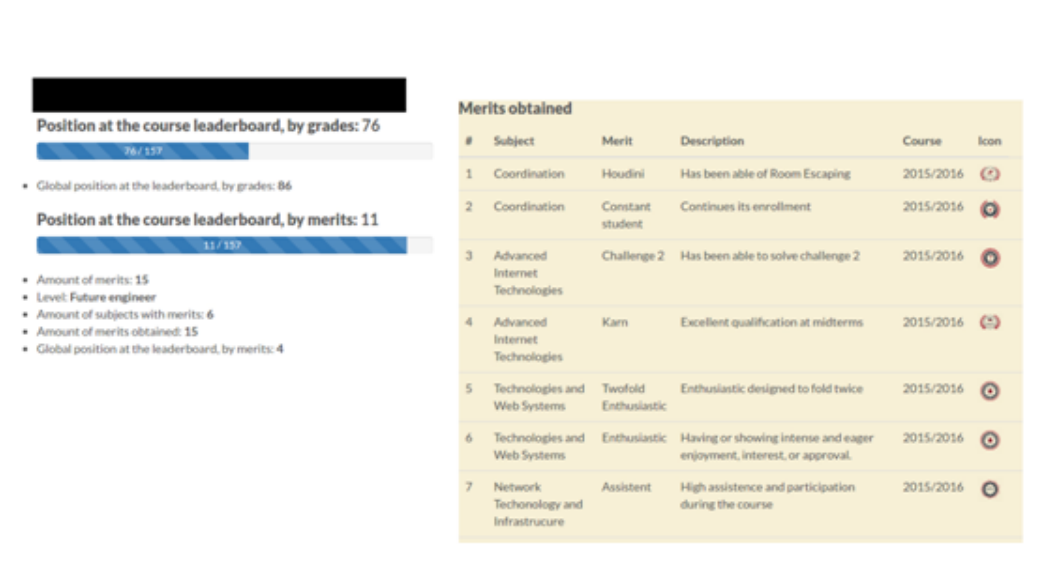
Figure 3. Example of the personal profile of a